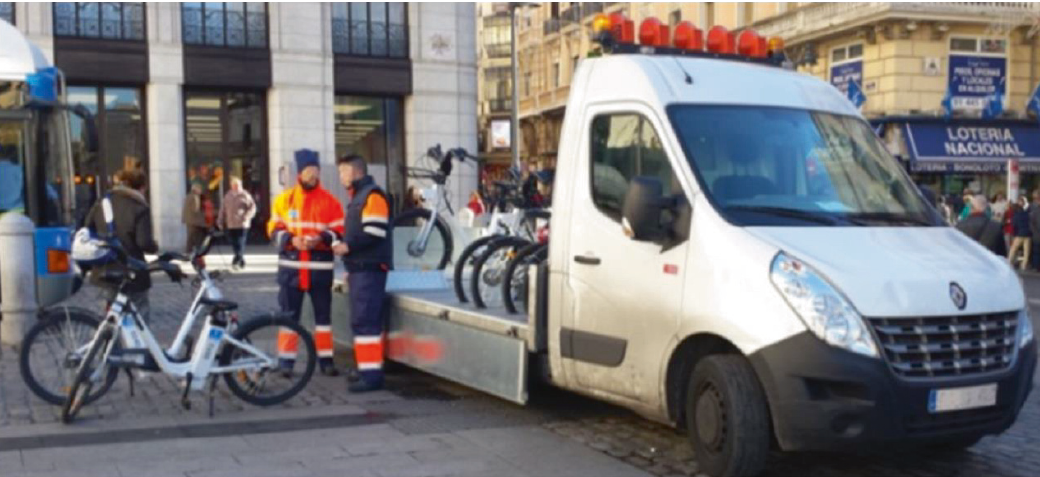
Figure 2: e-bike sharing system operators in Madrid